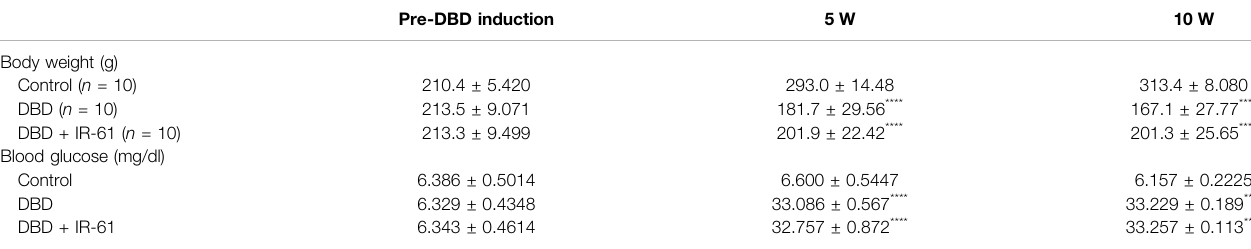
TABLE 1 | Changes in body weight and blood glucose levels in each group.